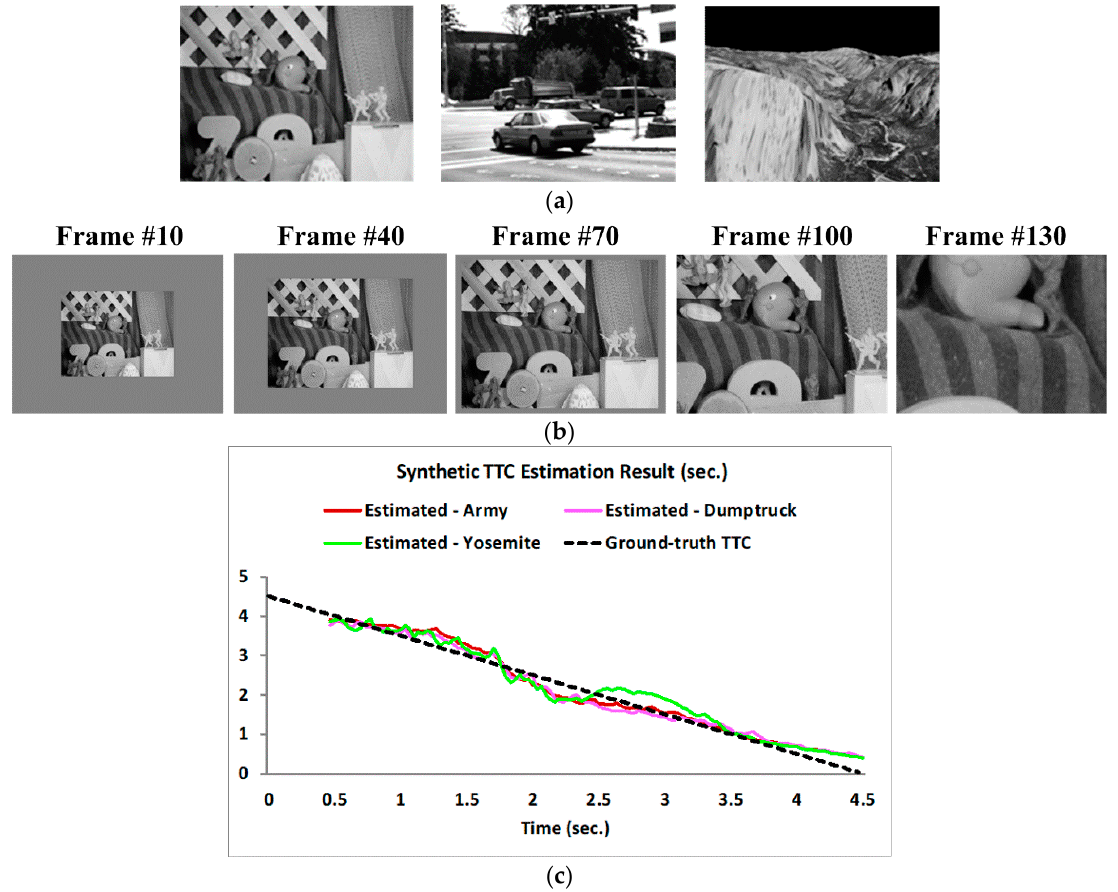
Figure 4. TTC estimation results for synthetic looming sequences. ( a ) Three Middlebury images selected to generate synthetic looming sequences. ( b ) One of the synthetic looming sequences: the Army looming sequence. ( c ) Global averages of estimated TTCs of the three sequences.